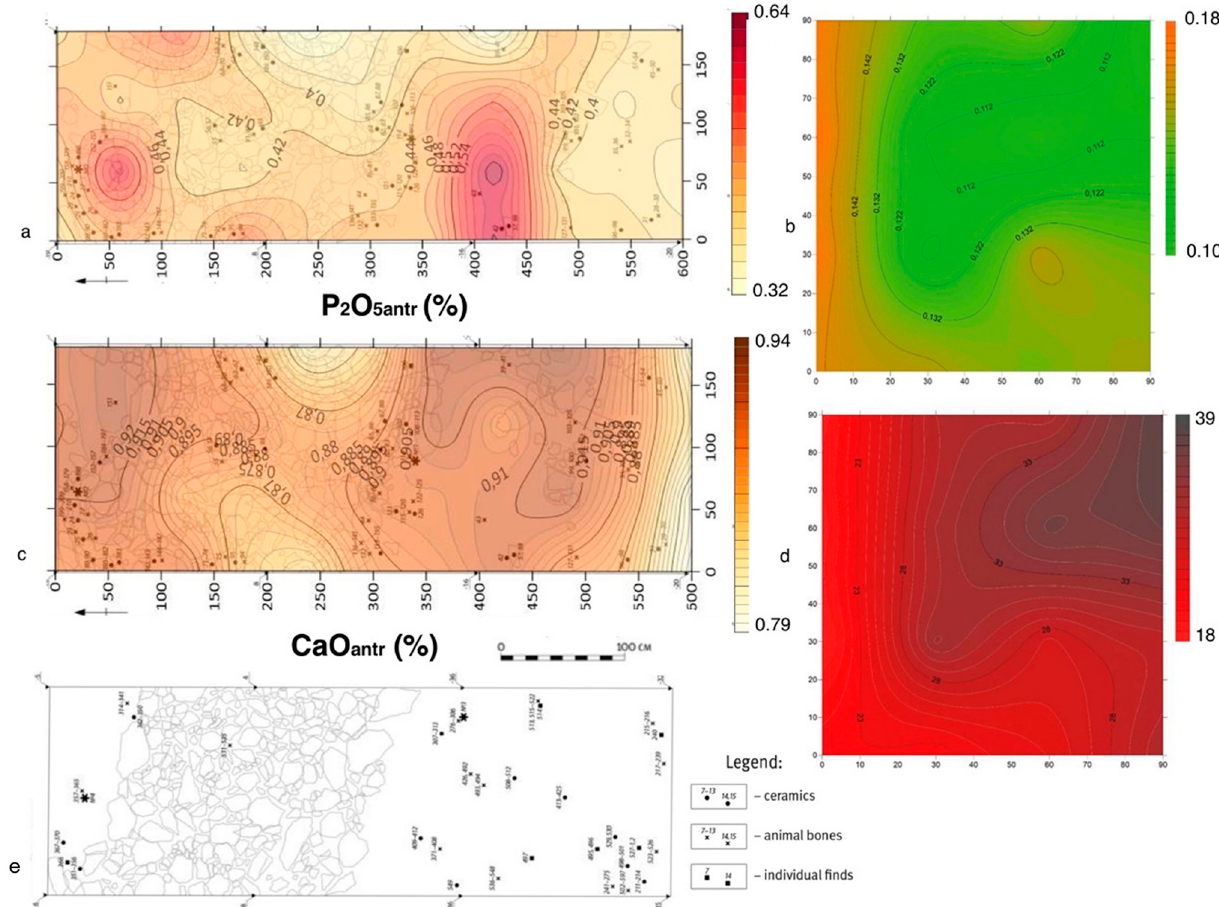
Figure 13. The Tarkhankhut 18 site. Geochemical maps of P 2 O 5 distribution in the sediments of ( a ) inside cattle pen; ( b ) background pit; geochemical maps of CaO distribution in the sediments of ( c ) inside cattle pen; ( d ) background pit; ( e ) archaeological plan of cattle pen [43], designed by